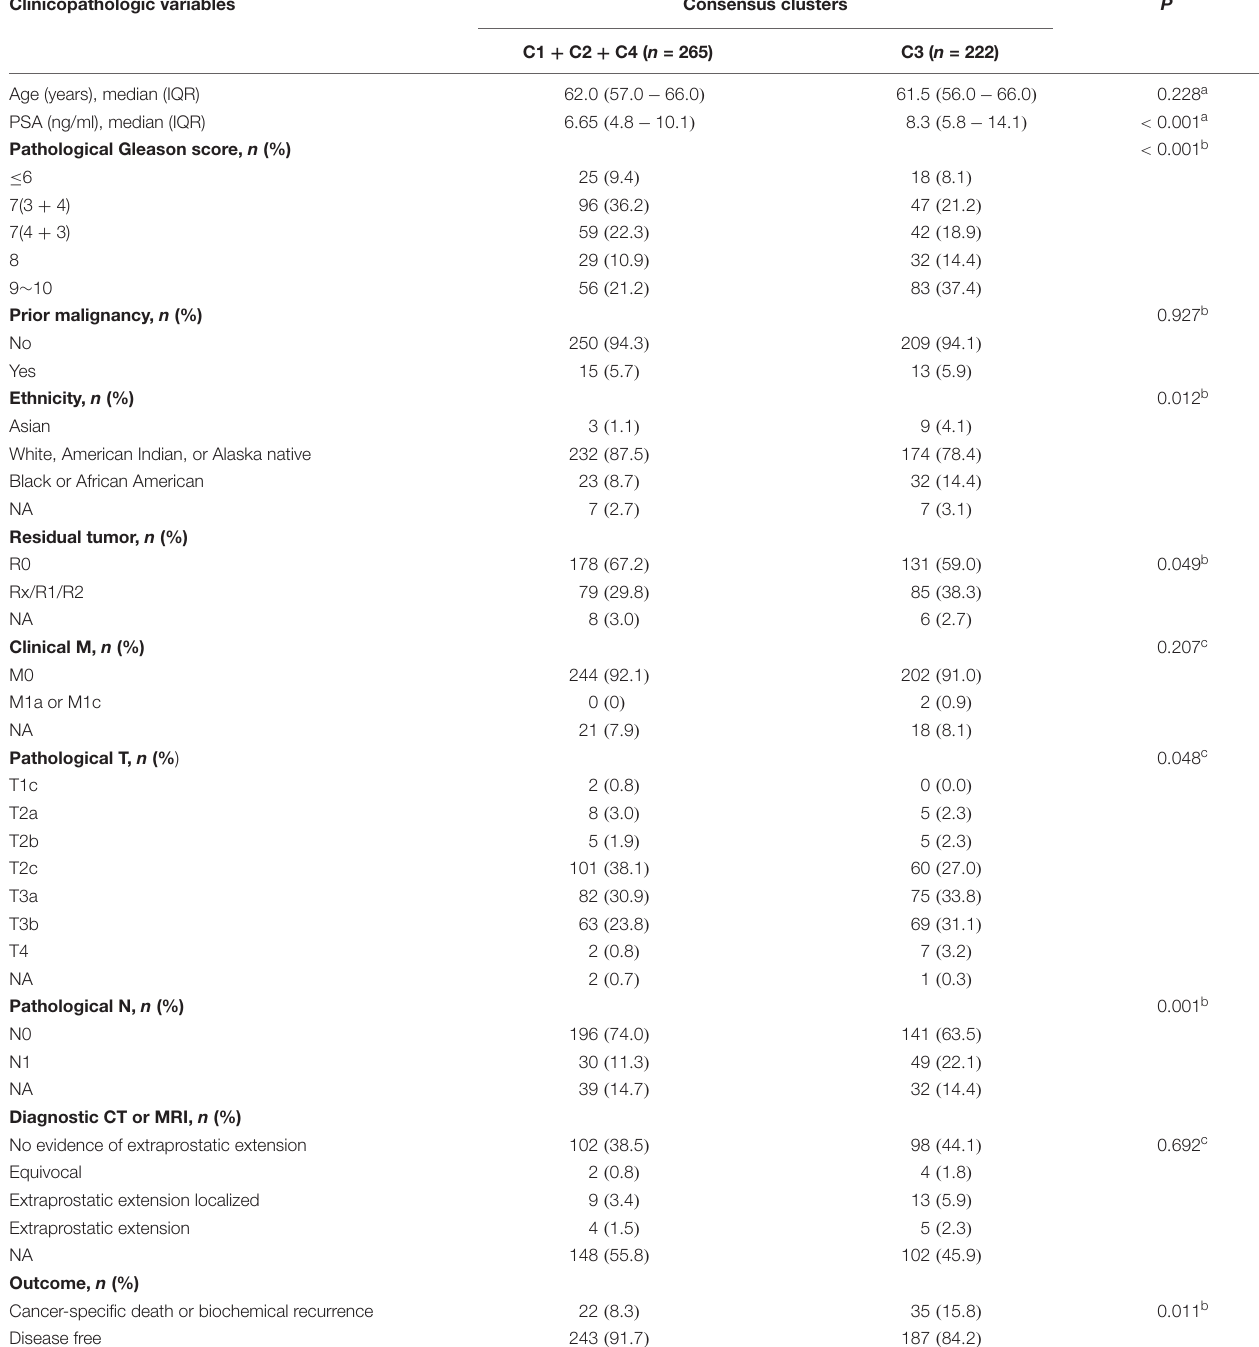
TABLE 3 | The association between consensus clusters and clinicopathologic variables of prostate cancer. Clinicopathologic